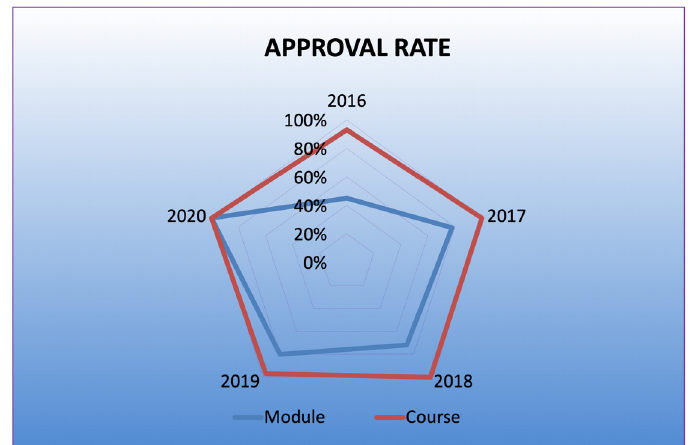
Figure 5. Comparative percentage of passing the module and the